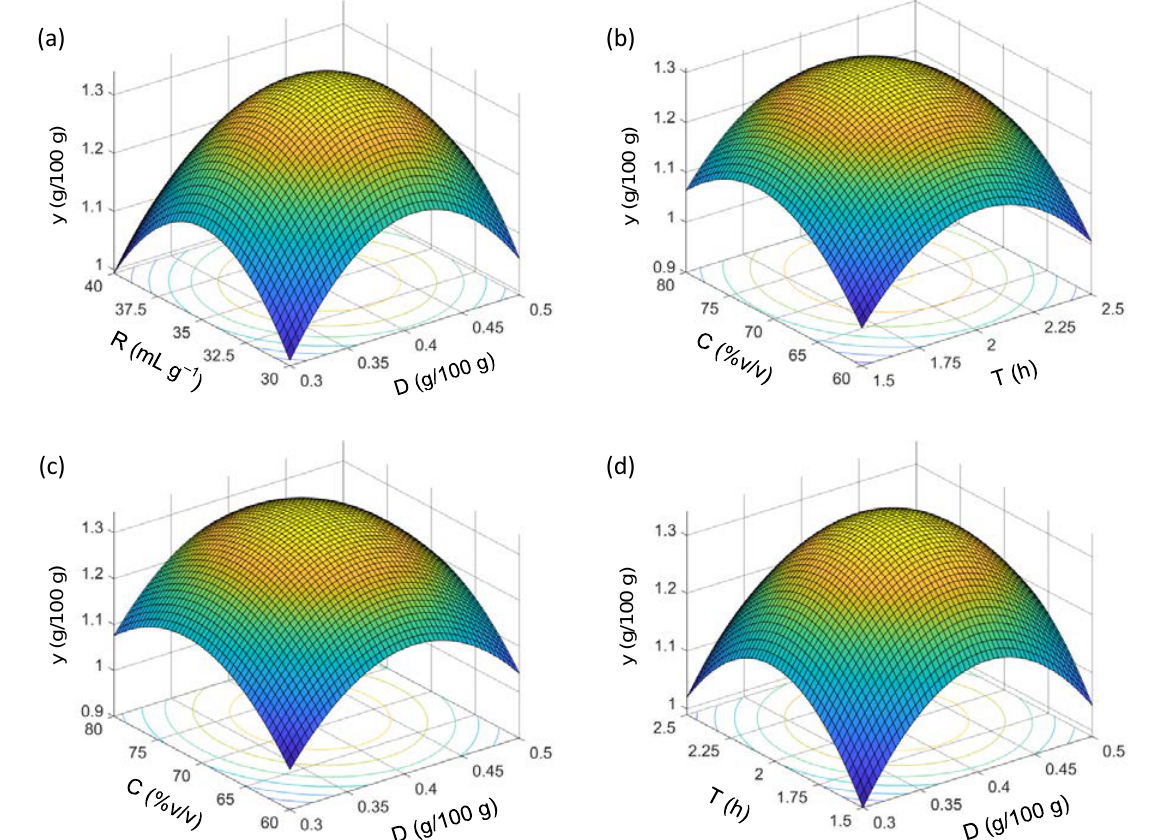
Figure 5. Response surface plots showing the influence of: (a) liquid-to-solid ratio (R) and enzyme dosage (D); (b) ethanol concentration (C) and incubation time (T); (c) ethanol concentration (C) and enzyme dosage (D); and (d) incubation time (T) and enzyme dosage (D) on the flavonoid extraction yield (y). For each plot, the levels of the other factors were held at their central values (D = 0.4 g/100 g, T = 2 h, R = 35 mL g −1 , C = 70% v/v).